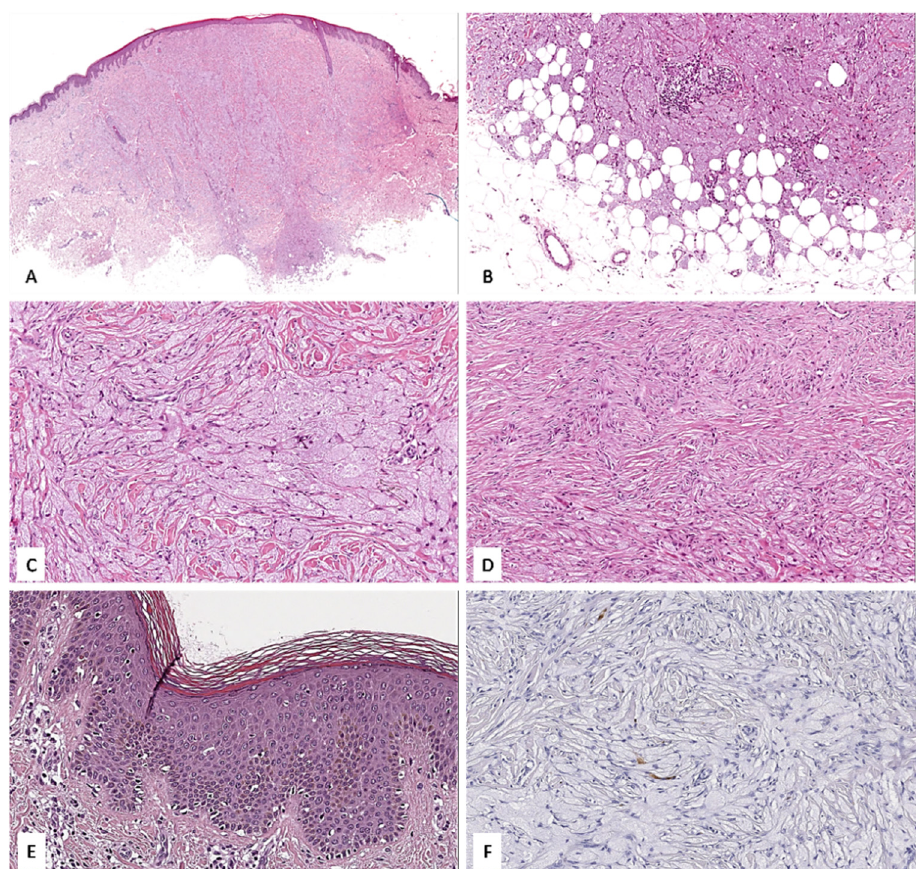
Figure 2. ( A ) Low magnification showing a dermal-based lesion with minimally-infiltrative margins (hematoxylin and eosin; original magnification 40×); ( B ) lesion shows focal extension to the subcutaneous adipose tissue (hematoxylin and eosin; original magnification 100×); ( C ) diffuse granular cell morphology (large-sized cells with large, clear to weakly eosinophilic, granular cytoplasm, and mildly hyperchromatic nuclei with inconspicuous nucleoli) is seen (hematoxylin and eosin; original magnification 200×); ( D ) areas with conventional morphology of cutaneous fibrous histiocytoma are focally found (hematoxylin and eosin; original magnification 100×). ( E ) Mild thickening and basal layer hyperpigmentation of the overlying epidermis are seen (hematoxylin and eosin; original magnification 250×). ( F ) Granular cells are not stained with anti- S100 protein antibody (immunoperoxidase; original magnification 200×).